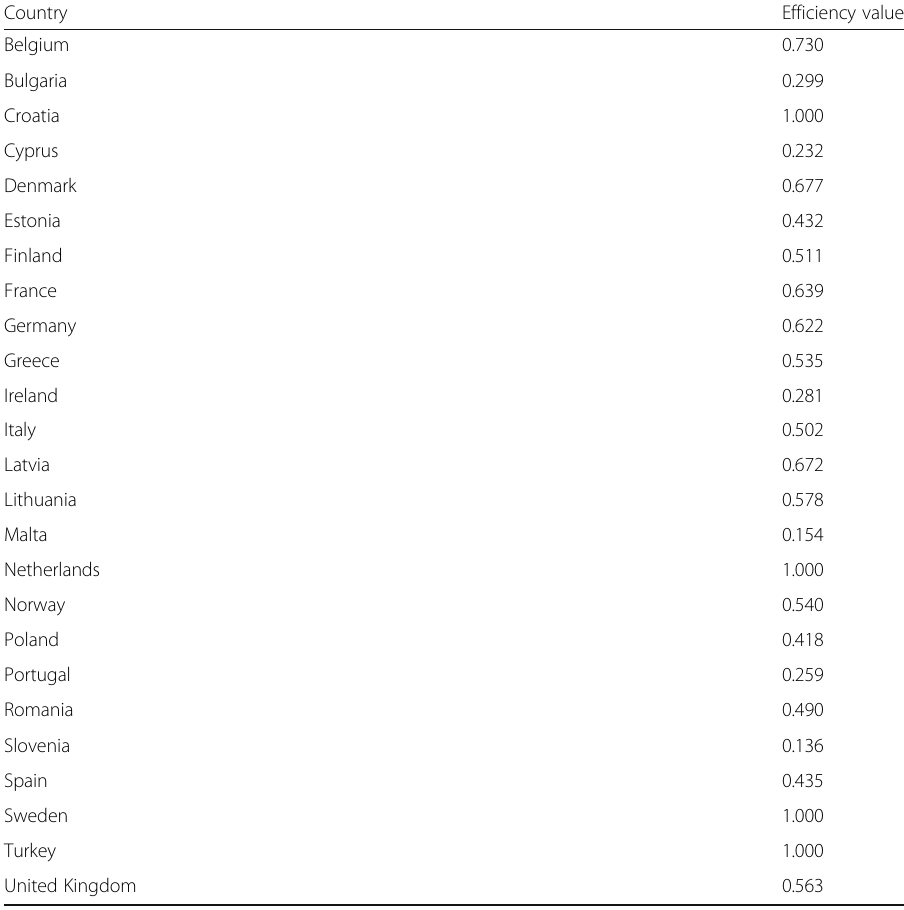
Country Efficiency